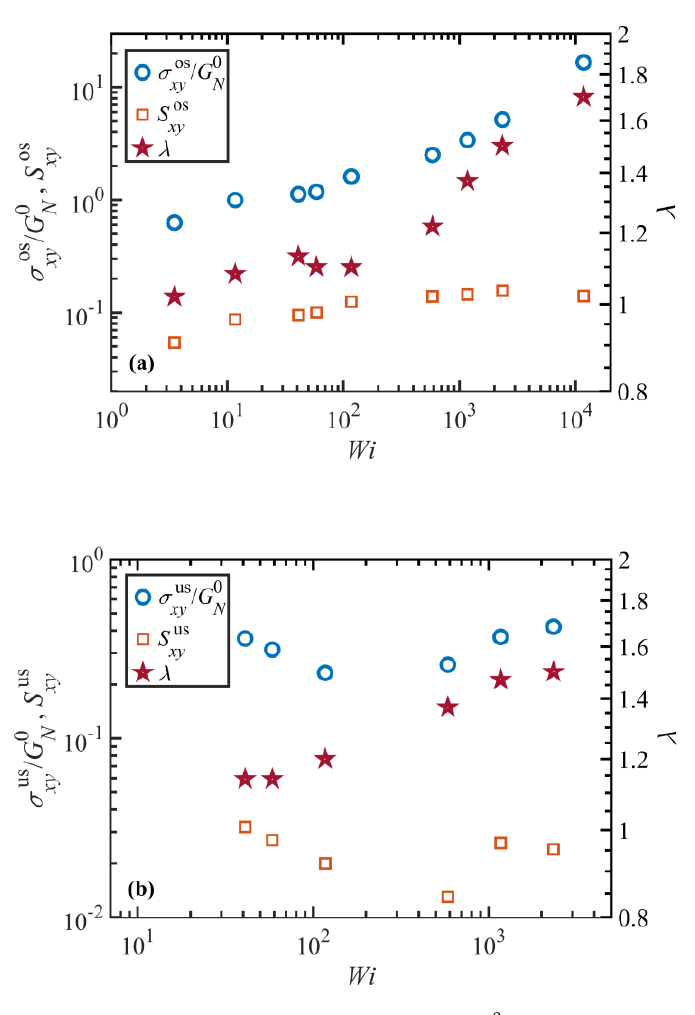
Figure 13. Magnitudes of the normalized shear stress, 𝜎 𝑥𝑦 /𝐺 𝑁0 , the 𝑆 𝑥𝑦 component of the tube orientation tensor, and the tube stretch 𝜆 at the stress overshoot ( a ) and undershoot ( b ) times versus 𝑊𝑖 . The stress overshoot scales as 𝑊𝑖 0.3 in the range 3.5 ≤ 𝑊𝑖 ≤ 2,340 , and the tube stretch at the stress overshoot time scales as 𝑊𝑖 0.1 for 𝑊𝑖 > 58 .